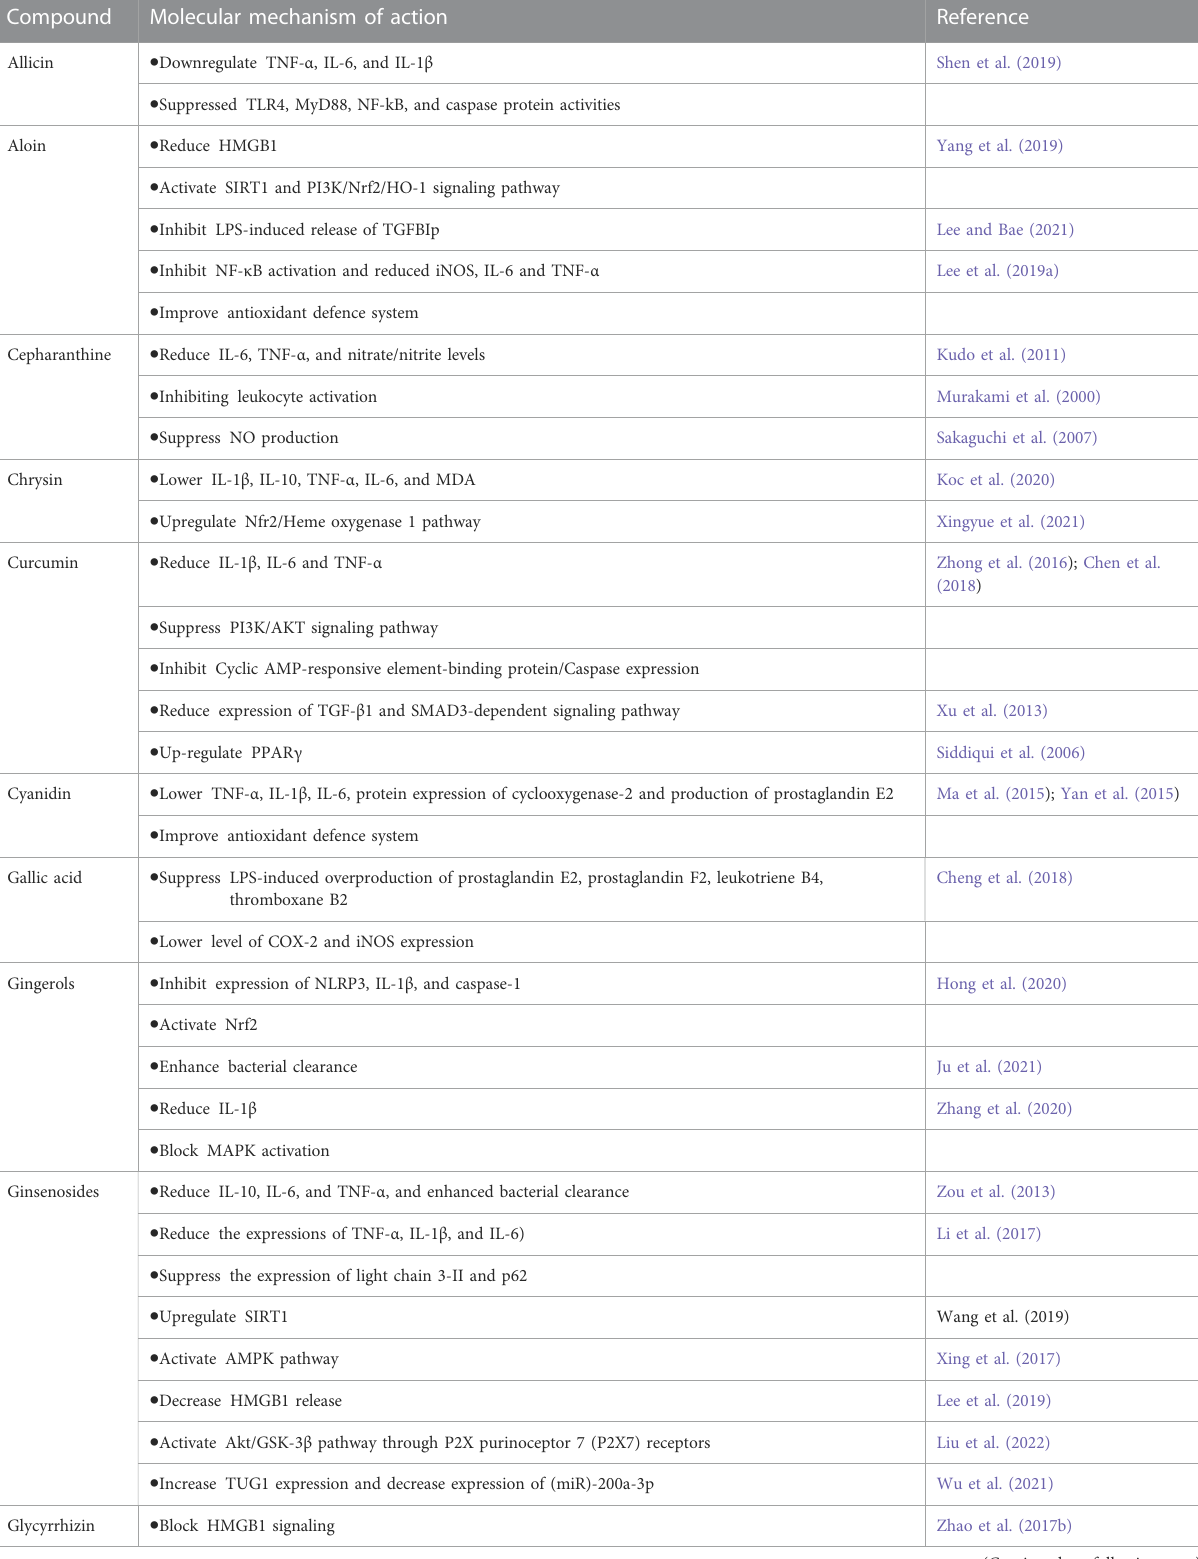
TABLE 1 Main mechanism of action of secondary metabolites in the management of